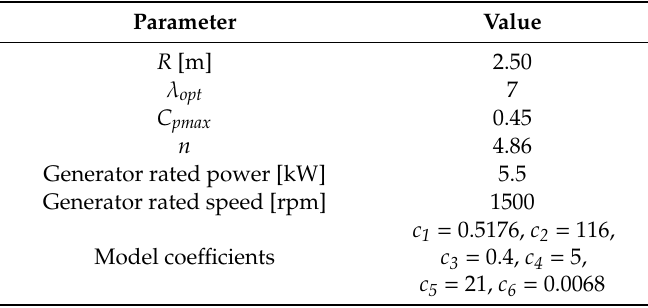
Table 2. Parameters of the considered horizontal axis wind